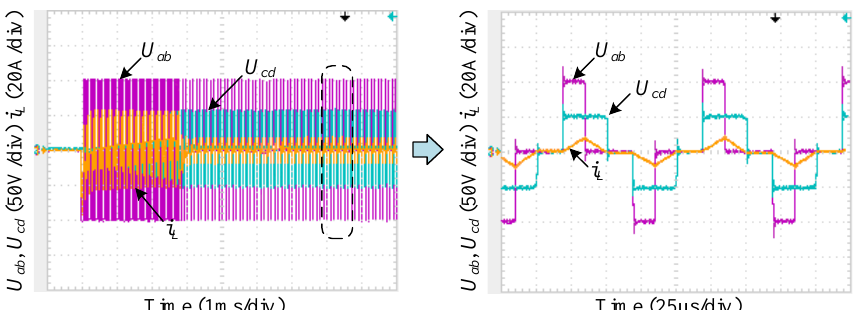
Figure 25. Start-up response of DAB converter under TPSiDT